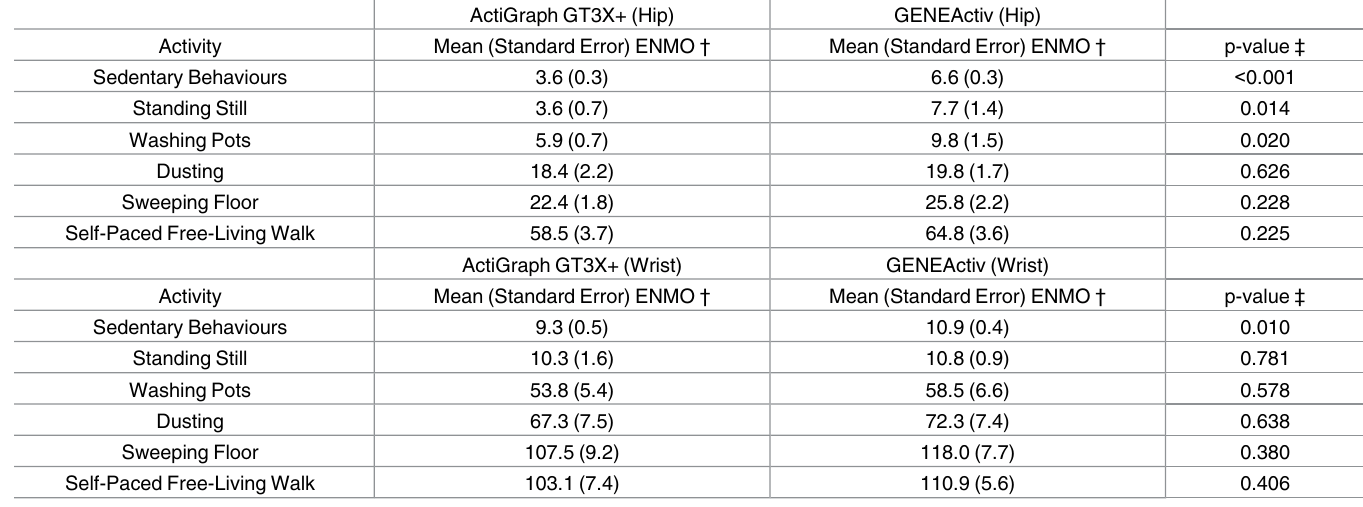
Table 2. Mean (Standard Error) Euclidean Norm Minus One (ENMO (measured in milligravity units)) values for each activity stratified by acceler- ometer brand and monitor placement.